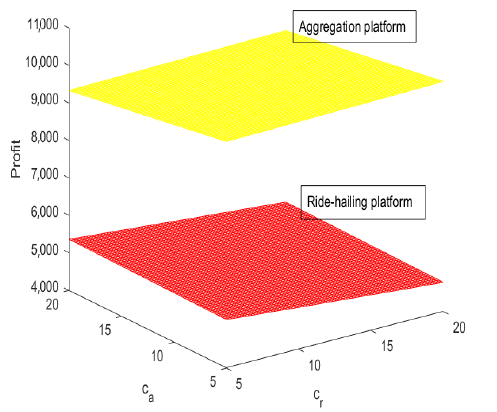
Figure 16. The profits of platforms with the combinations of c r and c a in Model N.